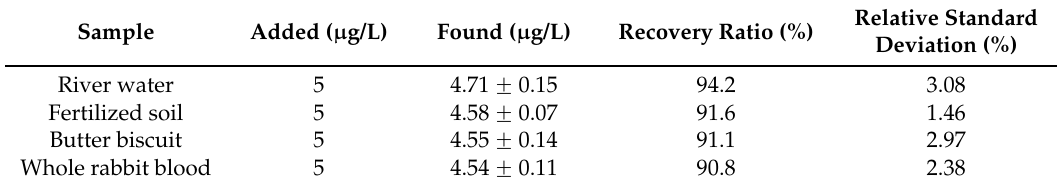
Table 8. Determination of the simulated ricin specimens by ECL immunosensor ( n = 4).